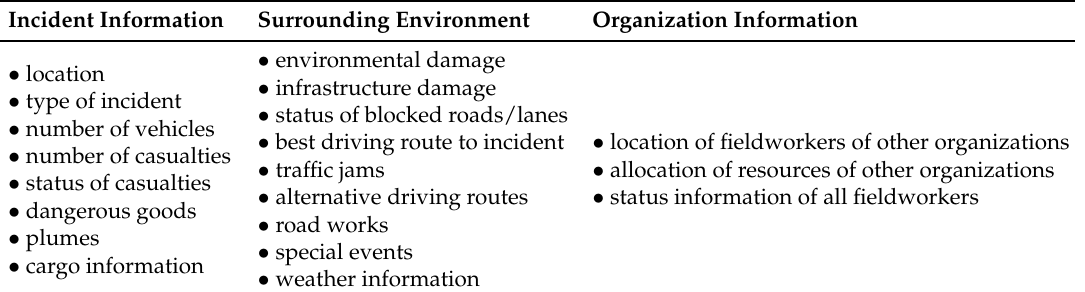
Table 1. Information categories for traffic incident management (extracted from